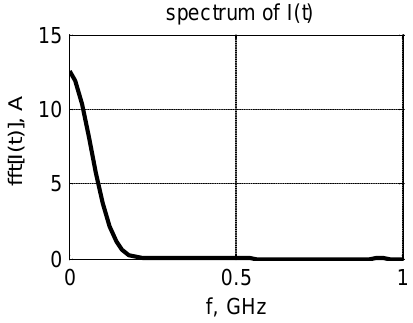
Figure 16: Frequency spectrum o f t he e xcitation signal I ( t ) shown in Figure